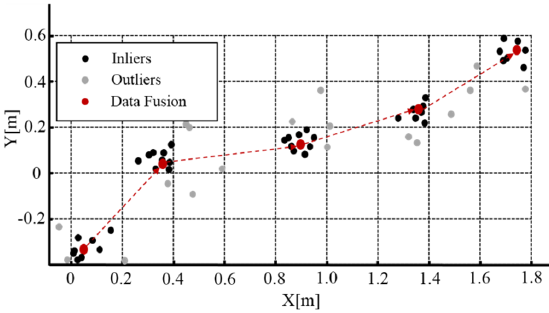
Figure 2. Occupancy grid based data fusion method for GPS–IMU and DR.